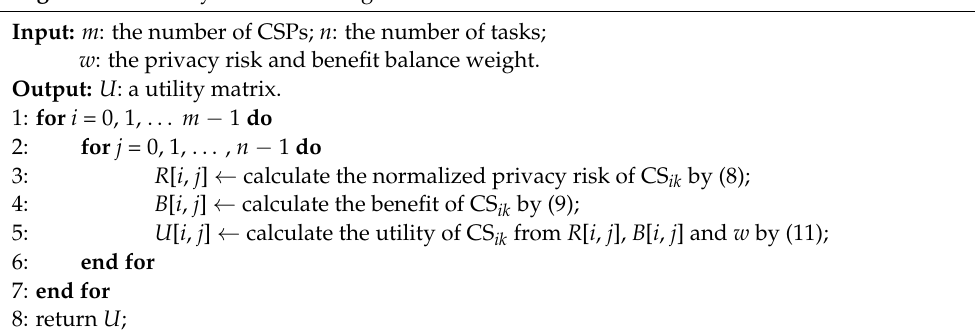
Algorithm 1: Utility matrix